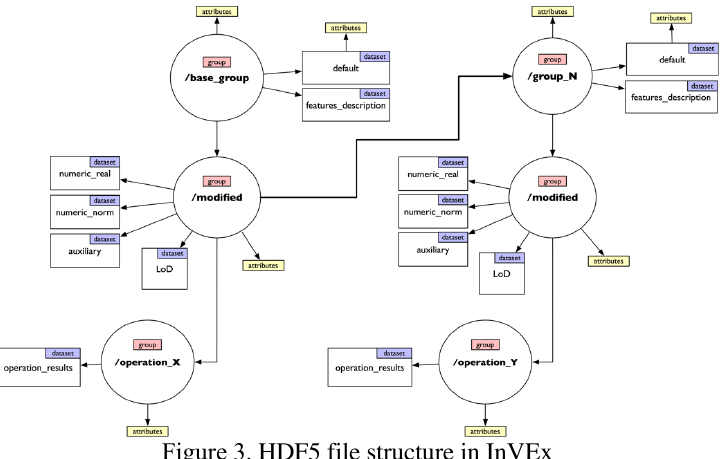
Figure 3. HDF5 file structure in